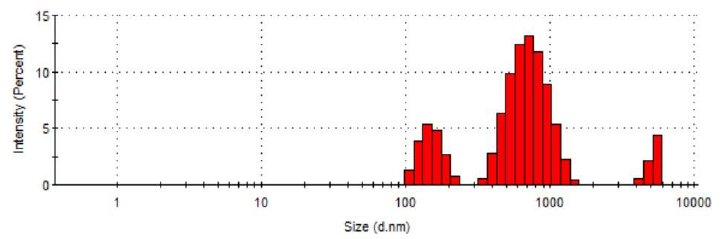
Figure 6. T he DLS size distribution profile of QA-PEI-NPs. Figure 6. The DLS size distribution profile of QA-PEI-NPs.